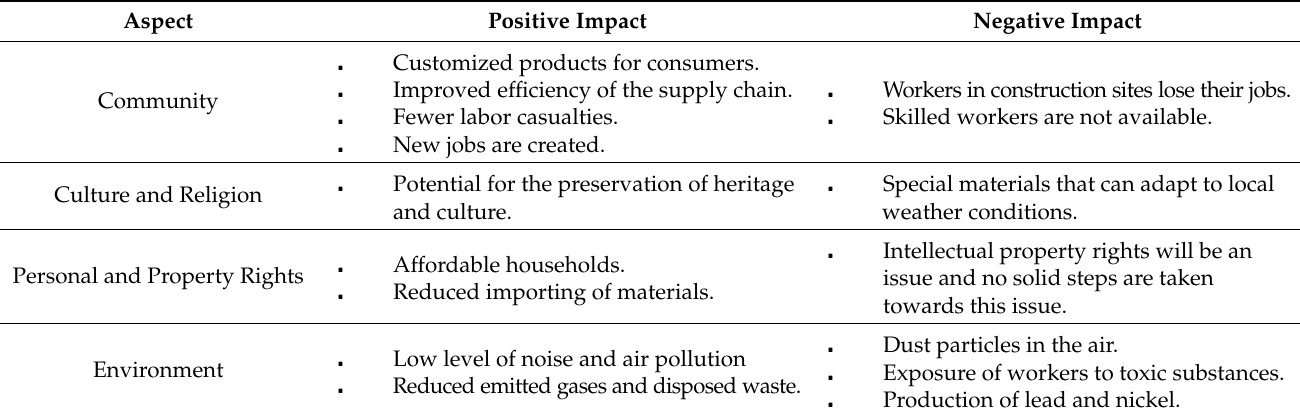
Table 4. Summary of the social impacts of 3DP